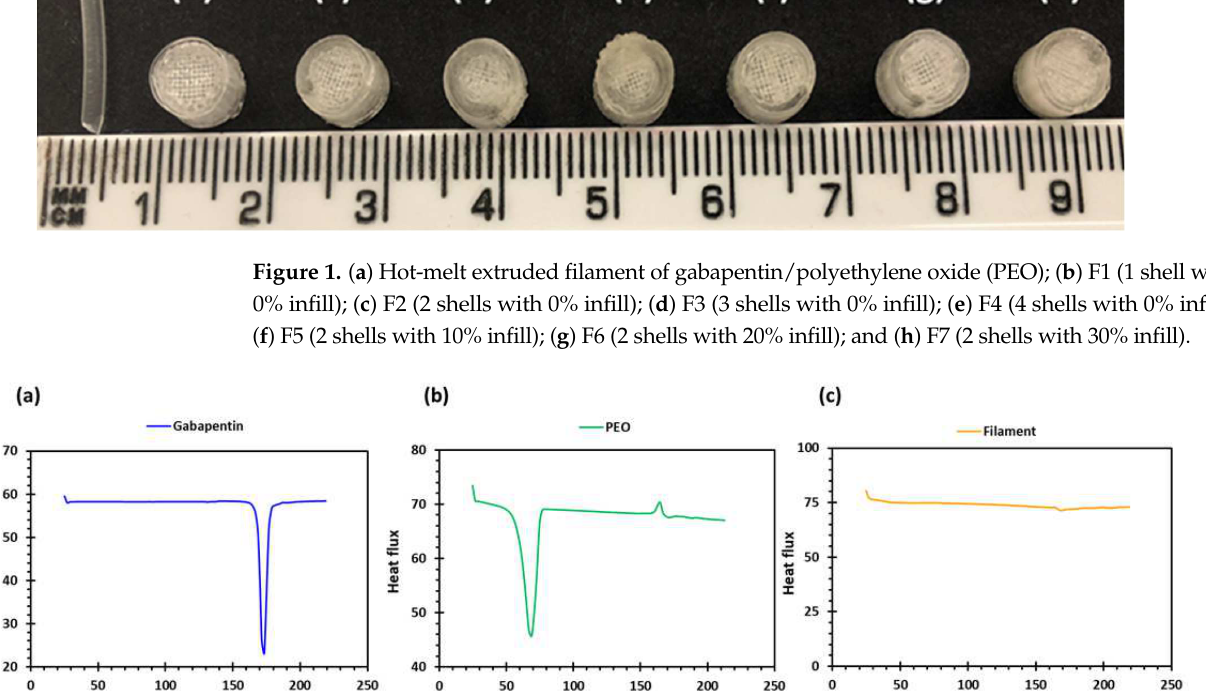
Figure 3. TGA profiles of ( a ) gabapentin; ( b ) polyethylene oxide (PEO); and ( c ) GBP/PEO filament. Figure 4. XRD profiles of ( a ) gabapentin; ( b ) polyethylene oxide (PEO); and ( c ) GBP/PEO filament. Table 1. Drug loading and three-point bending results of filaments ( n = 10, standard deviations are in parenthesis). Drug Loading (%)